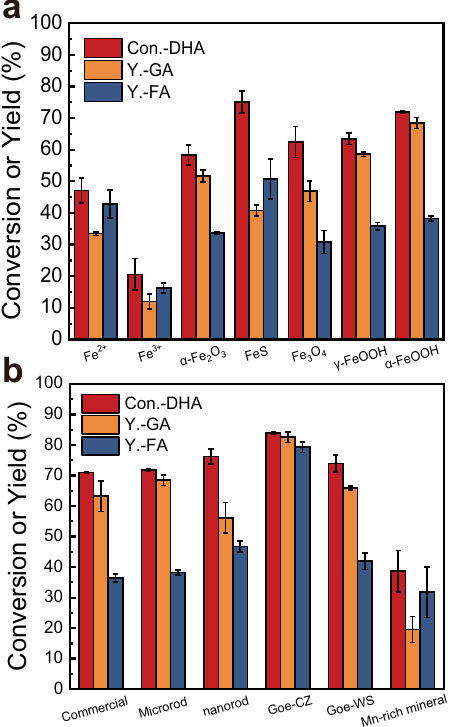
Fig. 1 Catalytic performance screening of iron-based catalysts. a Catalytic activity for DHA oxidation over Fe-based ions and different Fe-containing minerals. b Catalytic activity for DHA oxidation over different goethite and Fe-containing Mn-rich minerals. The commercially available goethite (Sigma, 30 − 50 mesh) was used after grinding to more than 200